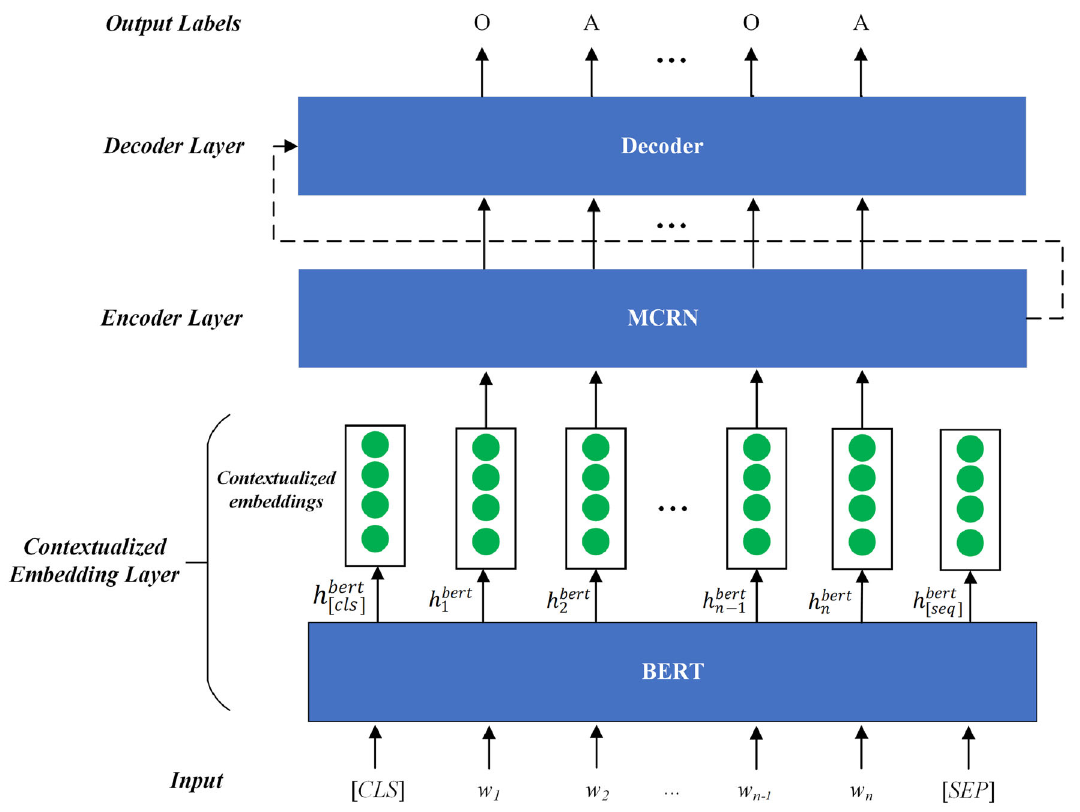
Fig. 2 The overall framework of IANN. The encoder layer is composed of the single-layer encoder in the current diagram. The output labels are the dual AO tags